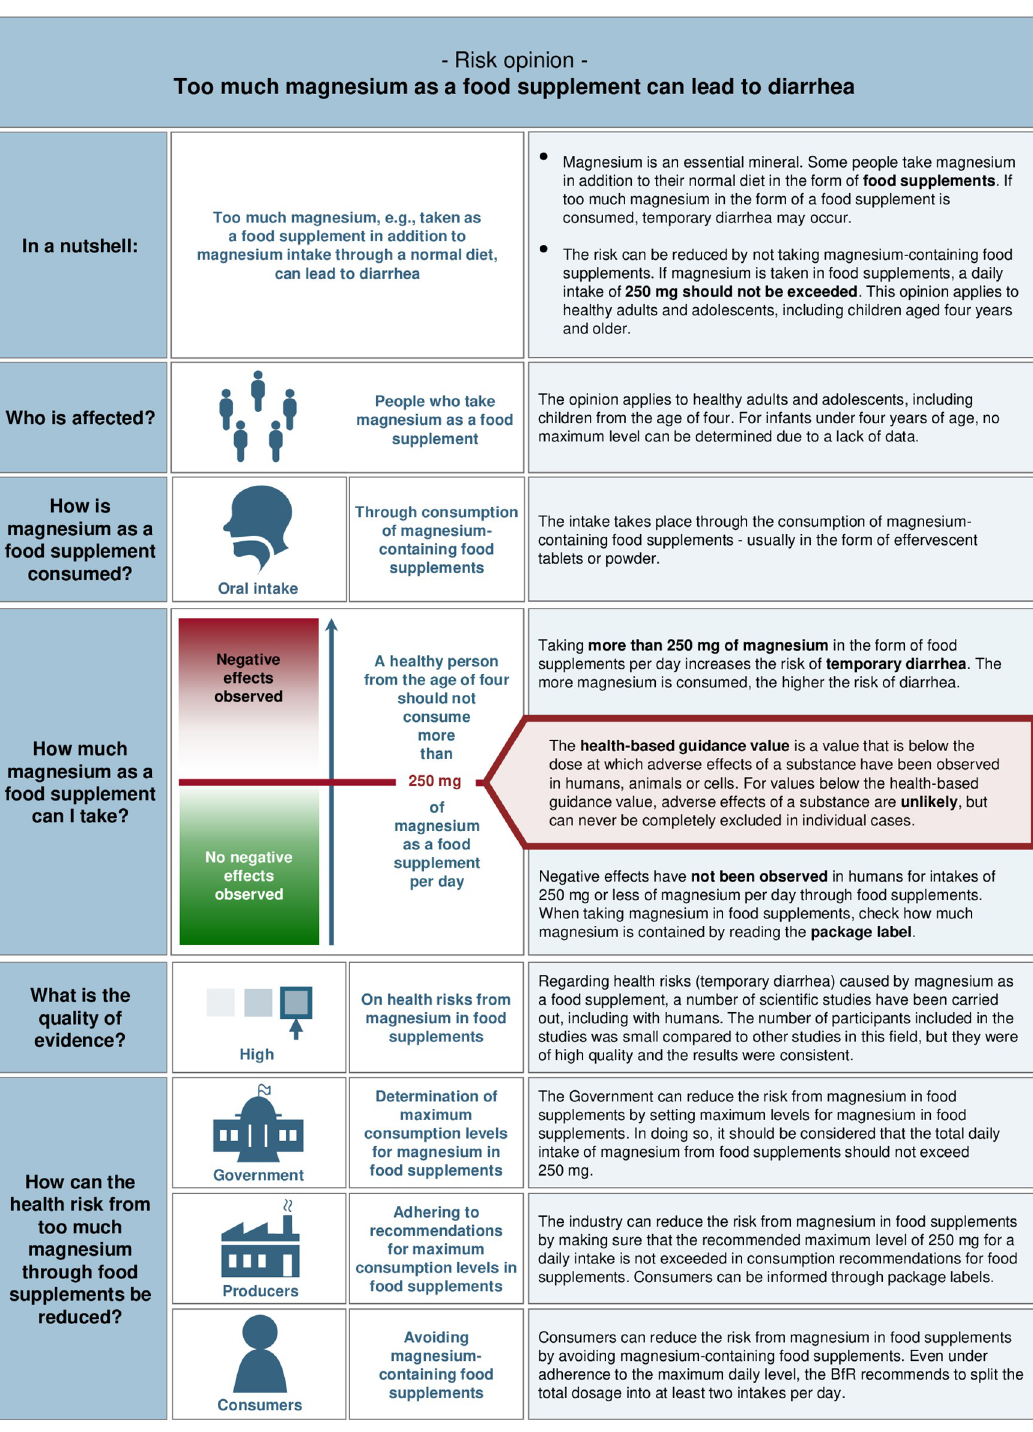
Fig 5. Final version of the 2020 Risk Profile on magnesium as a food supplement, as developed after usability testing.